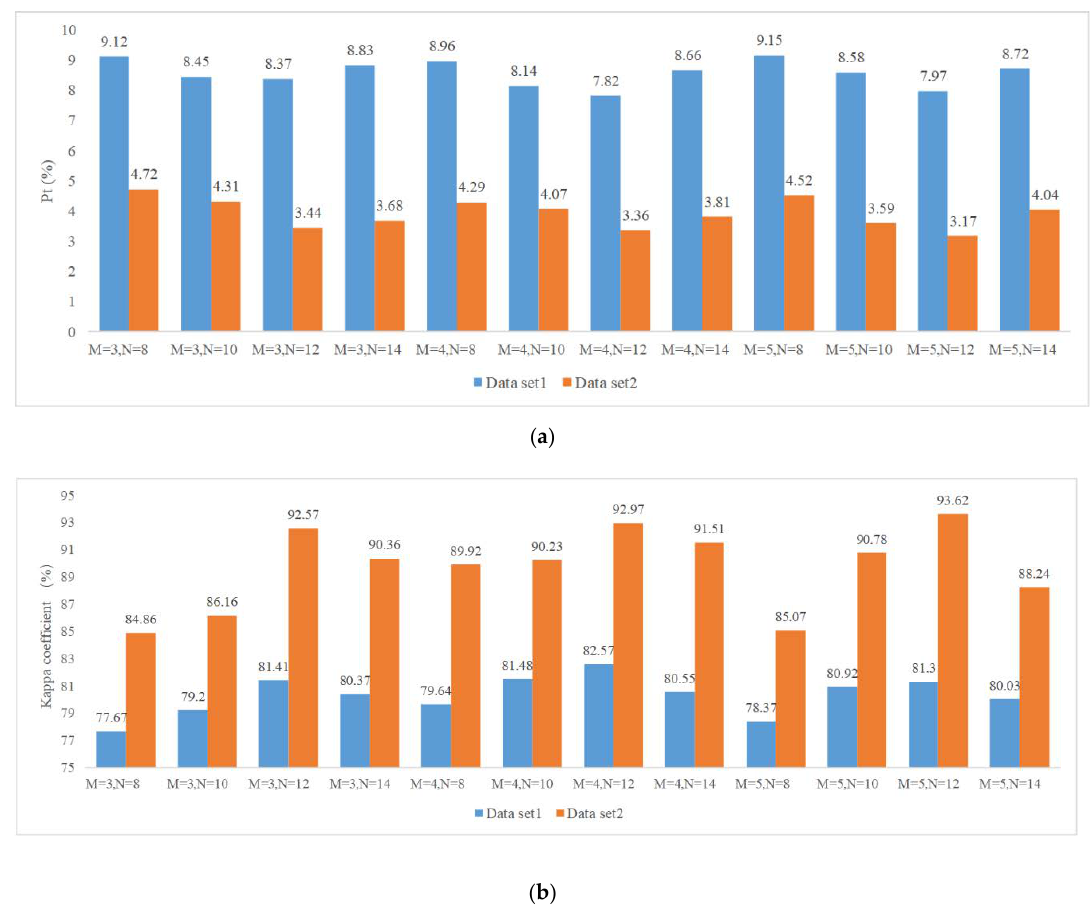
Figure 11. The relationship between the accuracy and different combinations of M and N. ( a ) the relationship between Pt and different combinations of M and N ; ( b ) the relationship between KC and different combinations of M and N .